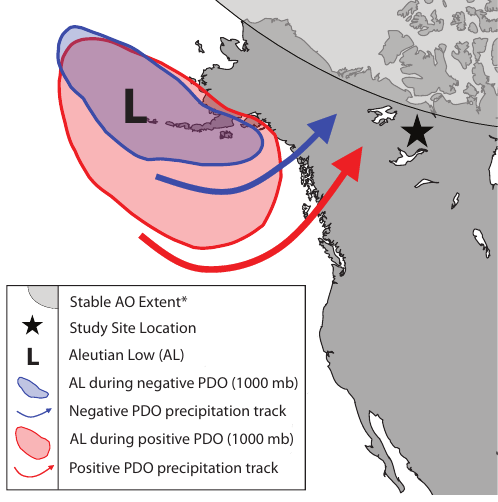
Figure 8. Position and strength of Aleutian low-pressure system during positive and negative phases of the PDO in relation to study site. Hypothesized stable Arctic Oscillation during the Eocene de- picted by gray arc in upper right corner (see Sewall and Sloan 2001). 1000mb sea level pressure (SLP) contours shown for negative PDO (blue shaded area) and positive PDO (red shaded area). Weather patterns are altered according to these changes in SLP (blue arrow – negative PDO, red arrow – positive PDO), thus altering the dis- tribution of precipitation across North America. Positions of 1000 mb contours of Aleutian low after NOAA-CIRES/Climate Diagnos- tics Center (Jan-Mar sea level pressure (mb) composite for negative PDO 1988, 1999; for positive PDO 1983, 1987, 1992,